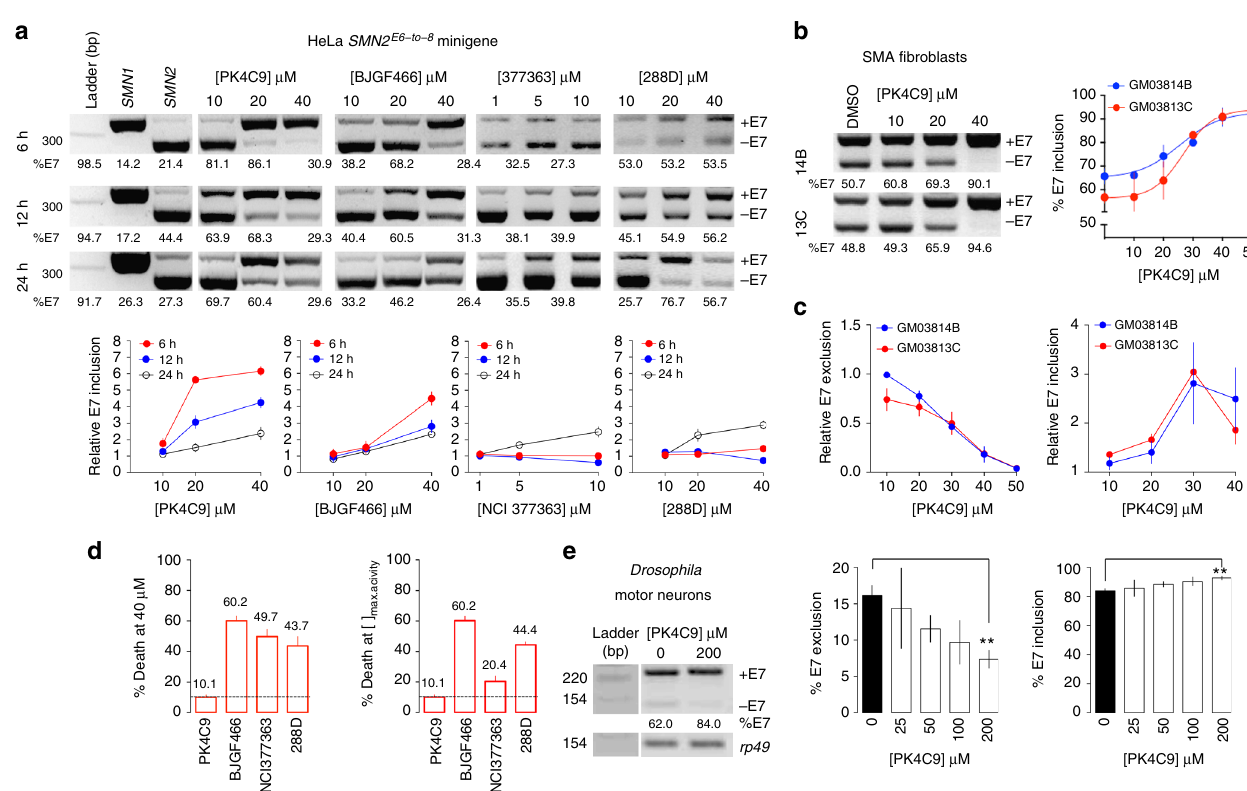
Fig. 3 TSL2-interacting small molecules increase SMN2 E7 splicing. a RT-PCR of exons 6-to-8 from HeLa cells transfected with SMN E6 − to − 8 minigenes 16 and treated with NCI377363 (1, 5 and 10 μ M), PK4C9, BJGF466 and 288D (10, 20 and 40 μ M) or DMSO (0.04%, controls) for 6, 12 and 24 h ( n = 6; three biological and two technical replicates). PK4C9 and BJGF466 elicit maximal E7 inclusion at early time points, which may be due to progressive compound toxicity and/or molecule secretion, as commonly seen in cancer cells. b , c RT-PCR ( b ) and qRT-PCR ( c ) showing the dose – response of PK4C9 in GM03813C (SMA) and GM03814B (parental carrier) fi broblasts after 24 h of treatment ( n = 6; three biological and two technical replicates). For simplicity, the ladder is shown in a . In RT-PCR, SMN2 isoforms including and excluding E7 are detected simultaneously. In qRT-PCR, SMN2 isoforms including and excluding E7 are ampli fi ed in two separate reactions. The dose – response curve of PK4C9 reveals a narrow concentration window but achieves maximal response. Concentrations higher than 50 μ M could not be measured due to poor solubility of the compound. d Twenty-four-hour cytotoxicity in GM03814B fi broblasts, using the lactate dehydrogenase (LDH) assay ( n = 12; six biological replicates and two technical replicates). PK4C9 showed the lowest toxicity when comparing all molecules at the same concentration (40 μ M; left) and the concentration of maximum splicing activity (right; PK4C9 40 μ M, BJGF466 40 μ M, NCI377363 10 μ M and 288D 80 μ M). Complete 24-h and 72-h cytotoxicity curves are shown in Supplementary Fig. 8. e RT-PCR from adult D42-Gal4>UAS-SMN2 E6 − to − 8 Drosophila fl ies expressing human SMN2 E6 − to − 8 in motor neurons. Flies were free fed with PK4C9 (25, 50, 100 and 200 μ M) or DMSO (0.5%, controls) as larvae. rp49 is the loading control ( n = 3 biological replicates of 10 – 12 individuals each), ** p < 0.01. p -values were obtained by applying non-paired, two-tailed t tests with Welch corrections. All graphs represent mean values ±